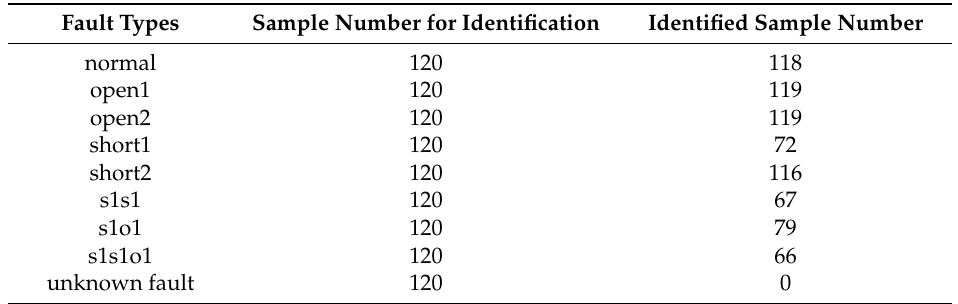
Table 7. Eight fault and unknown fault identification accuracy in testing phase of the field experiment.